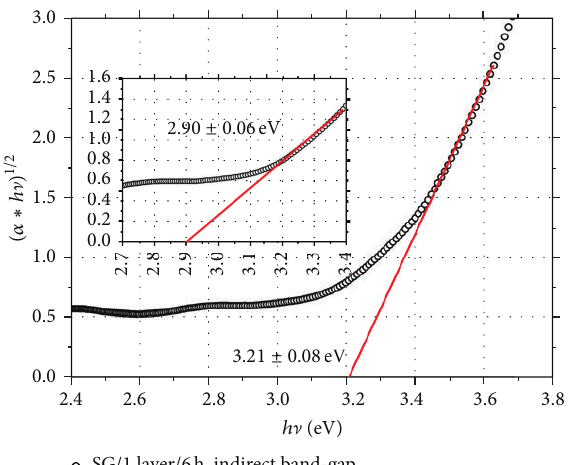
Figure 7: Tauc plot [25] of SG/1 layer/6 h photoelectrode. The indirect band-gap extrapolated from the plot is 3.21 ± 0.08 eV. An additional tail for a sub-band-gap of 2.9 ± 0.06 eV is also present. This indicates the presence of oxygen vacancies (shallow donors) withinthephotoanodesandexplainsthesmallIPCEsignalobserved for the photoelectrodes above 400